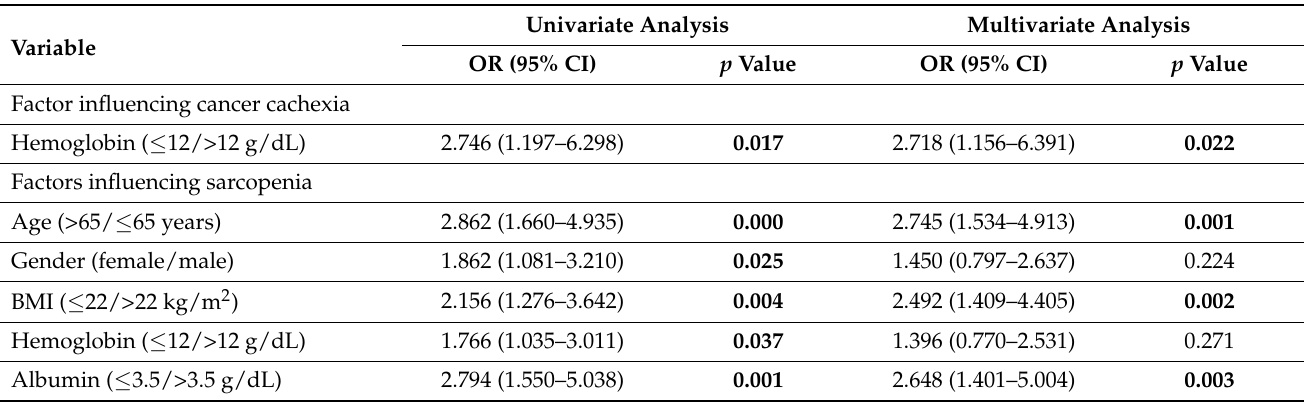
Table 3. Univariate and multivariate analysis of the investigated factors for predicting patients with cancer cachexia or